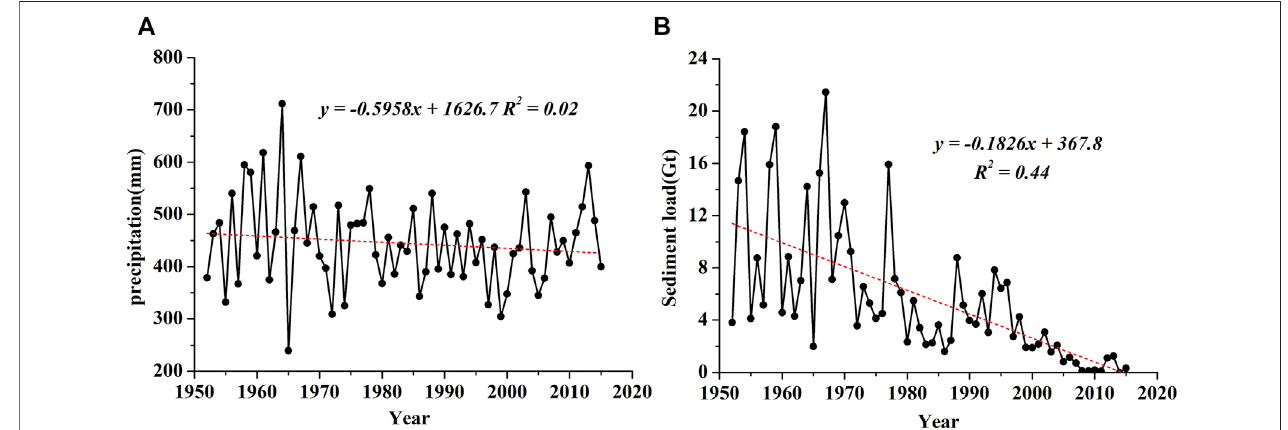
FIGURE 3 | Variations in (A) precipitation and (B) sediment load in the Hekou-Longmen